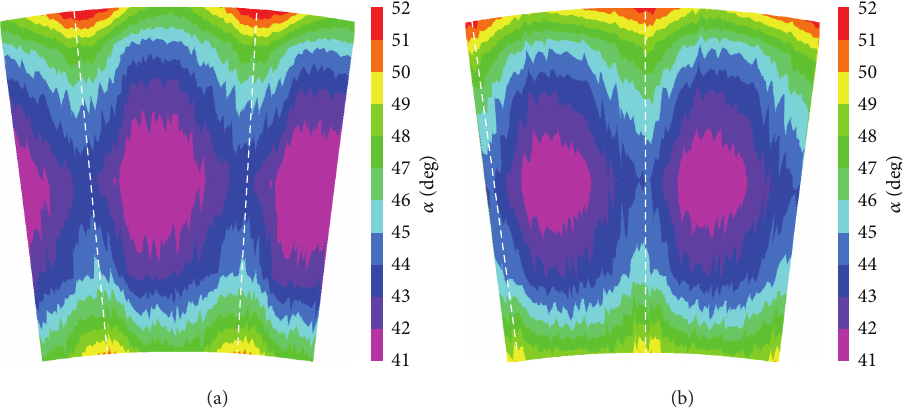
Figure 3: Time averaged absolute flow angle at Rotor 2 exit for CL3 (a) and CL6 (b).